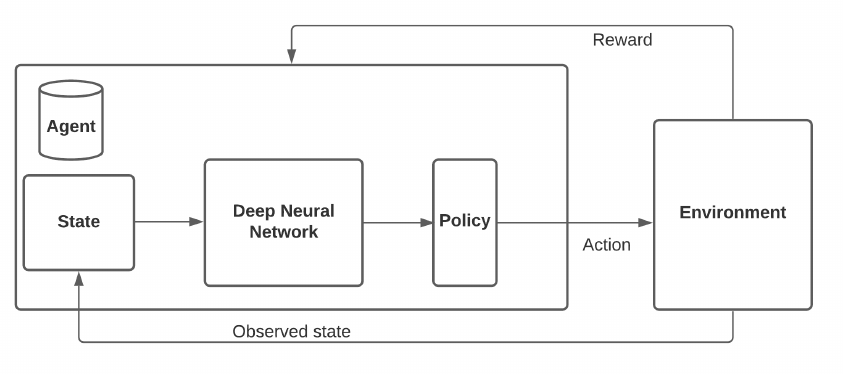
Figure 4. Main blocks of a common deep-reinforcement-learning-based traffic-signal-control model (adapted from Hussain et al.